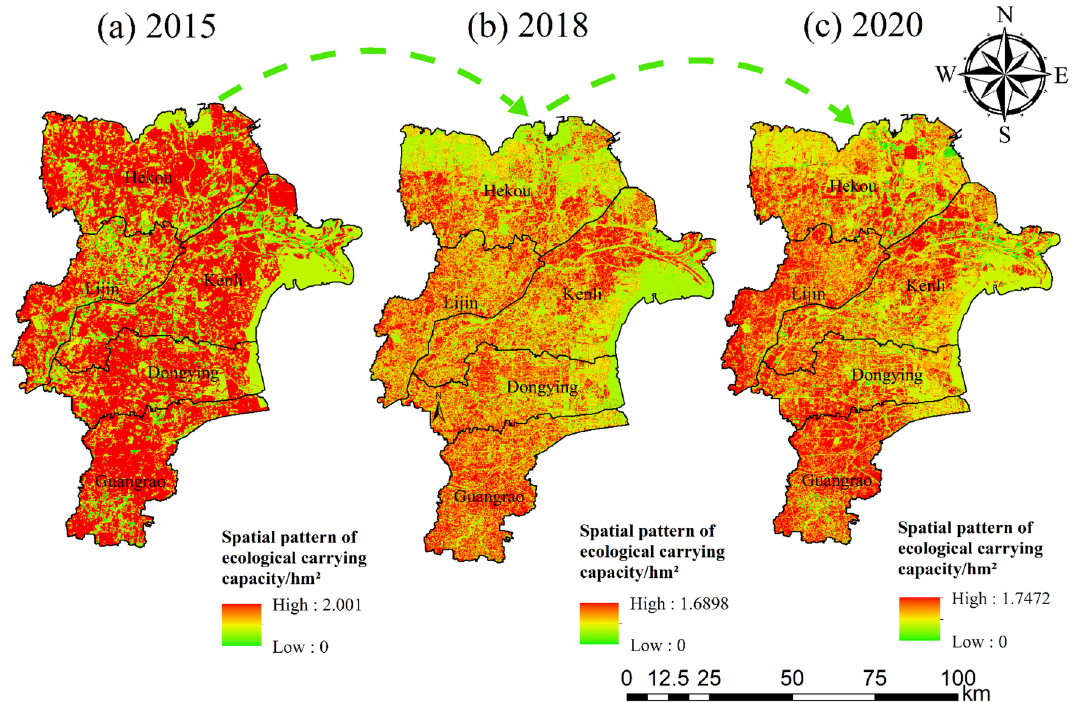
Figure 8. Spatial heterogeneity of ecological carrying capacity in 2015 ( a ), 2018 ( b ) and 2020 ( c ). This figure was created with ArcGIS 10.2 (https:// suppo rt. esri. com/ en/ downl oad/ 2093).